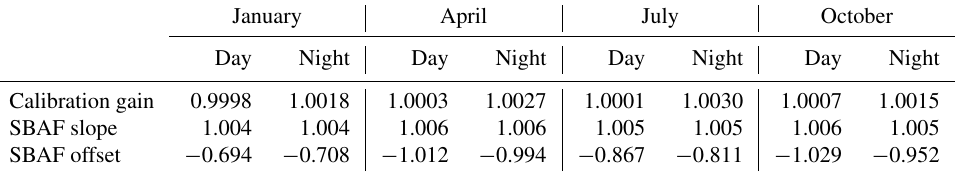
Figure 8. Mean regional GOES-East–GOES-West LST differences for July 2013. (a) Day without correction, (b) day with anisotropic correction, (c) night without correction, and (d) night with anisotropic correction. Table 2. Seasonal and diurnal calibration gains for 2013 based on a satellite ray-matching calibration technique described by Minnis et al. (2002). The gain coefficients derive from the ratio of mean GOES-13 and Aqua MODIS time-, space-, and angle-matched radiances, later converted to brightness temperature (BT). A MODIS-consistent GOES-13 BT is attained by multiplying the appropriate gain with GOES-13 BT values. The gains include adjustment for the spectral band difference between the GOES and MODIS channels following the technique described by Scarino et al. (2016). Those spectral band adjustment factor (SBAF) slope and offset values were applied to MODIS BT values (converted from radiance) during the cross-calibration in order to yield MODIS BTs that were spectrally consistent with GOES-13. January April July